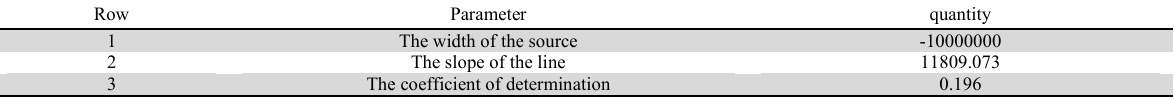
Paramete The width of the The slope of th e coefficient of